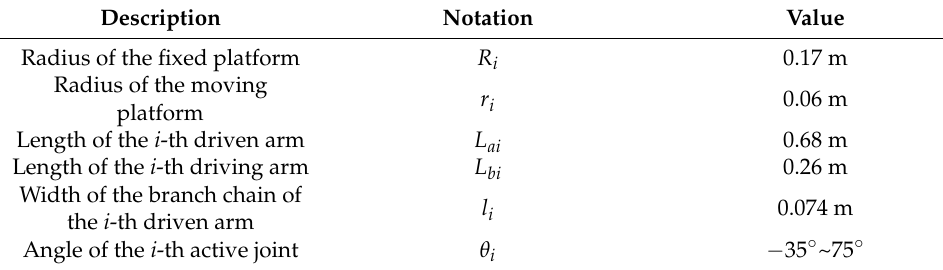
Table 1. Geometrical parameters of the Delta robot.